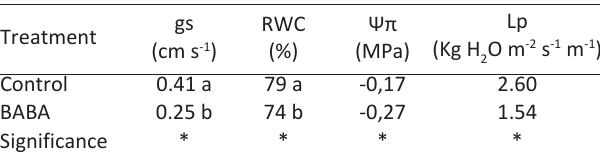
Table 2 - Effect of exogenous β-aminobutyric acid (BABA) on stomatal conductance (gs), relative water content (RWC), osmotic potential (Ψπ) and water conductivity (Lp) of rose cut stems